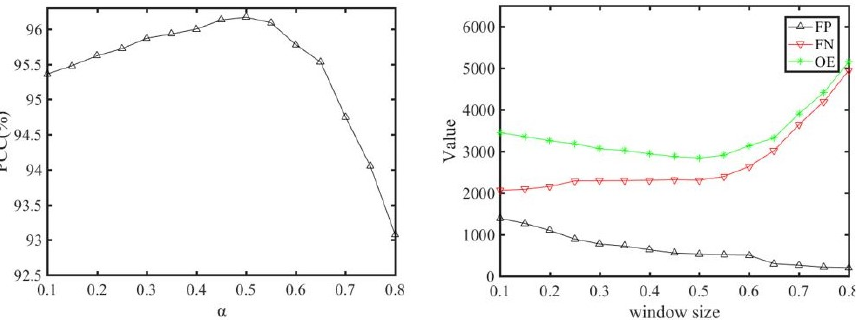
Figure 24. The influence of α evaluated on the Farmland D dataset.